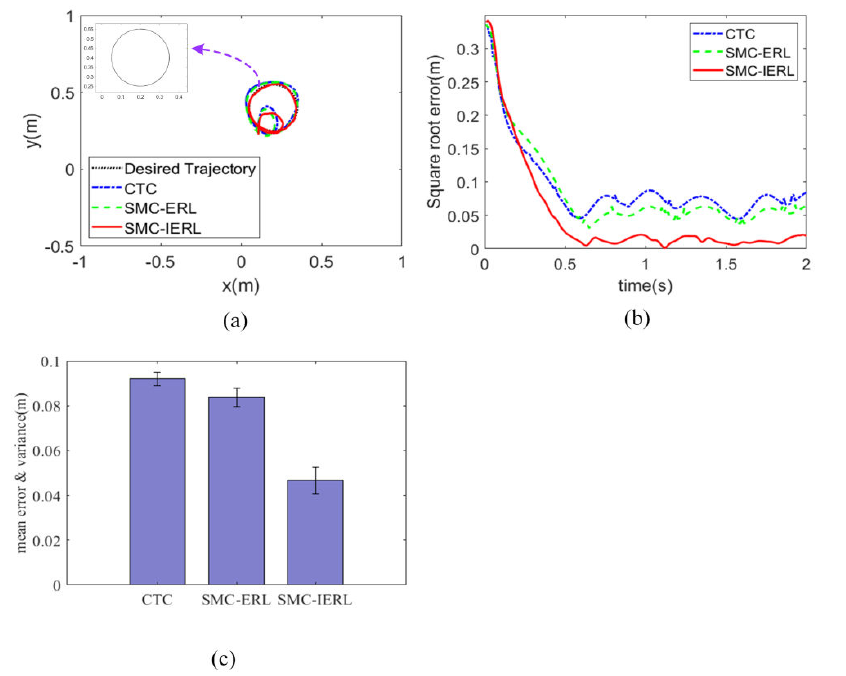
Figure 3. Uniform circular trajectory tracking experiment without considering disturbance signal. ( a ) comparison of trajectory tracking for desired uniform circular trajectory with three control algo- rithms; ( b ) comparison of square root error of three control algorithms; ( c ) comparison of mean error and variance of three control